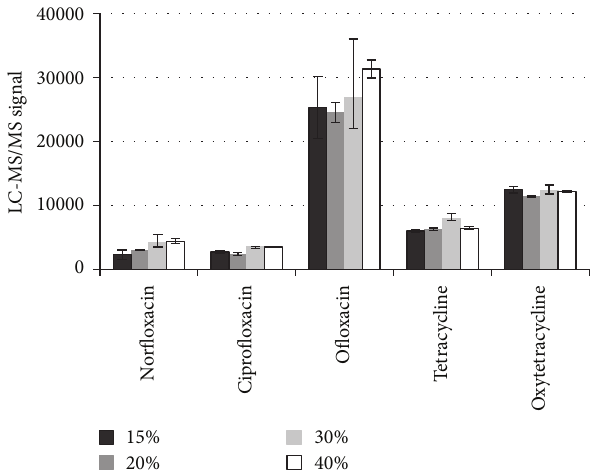
Figure 2: Signal response of some tetracyclines and fluoro- quinolones as a function of the percentage of DMSO in 1mL of